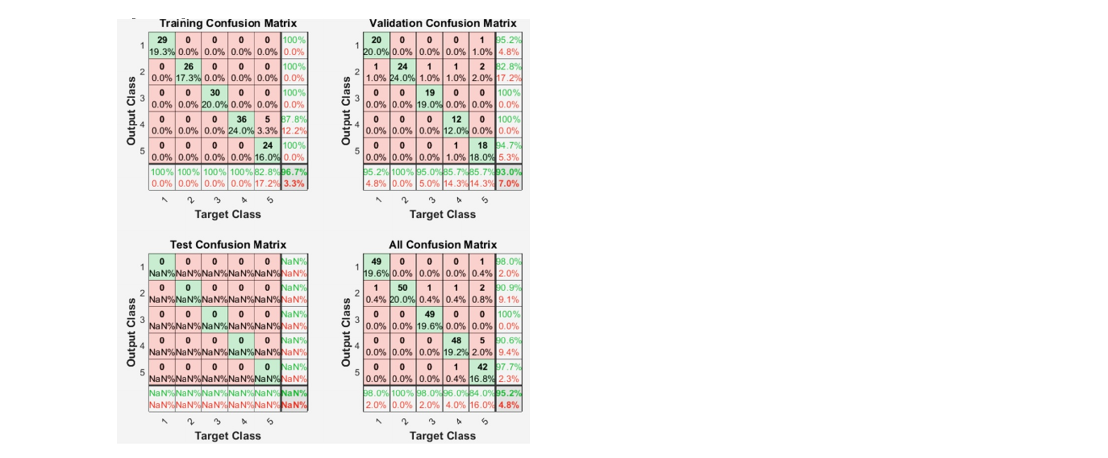
Figure 17. Confusion matrix related to the training and validation of the characterized EMG signals.